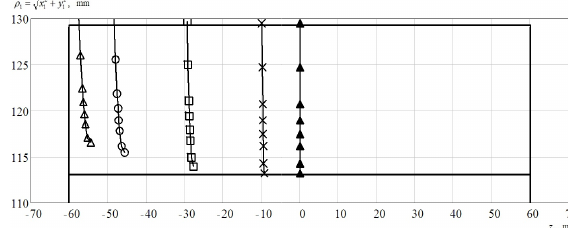
Figure 6. Active lines of action in meshing η =0 ( ▲ ); 1´ ( × ); 3´ ( □ );5´ ( ○ ) and 7´ ( ∆ ) (variant 2) Figure 7 illustrates the position of active lines of action on the flank of the gear tooth of the studied gear (variant 1) when the gear and wheel axes are twisted; γ =0´; 1´; 3´; 5´ and 7´.